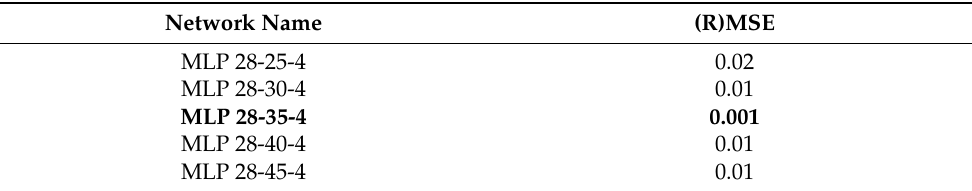
Table 5. MSE values for the best MLP neural network.